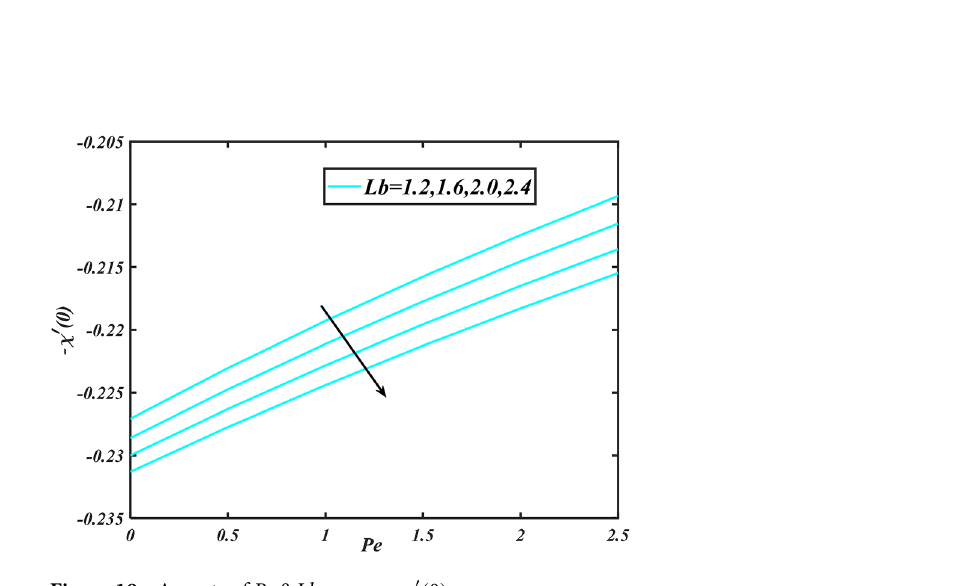
Figure 18. Aspects of Pe & Lb versus − χ ′ ( 0 )